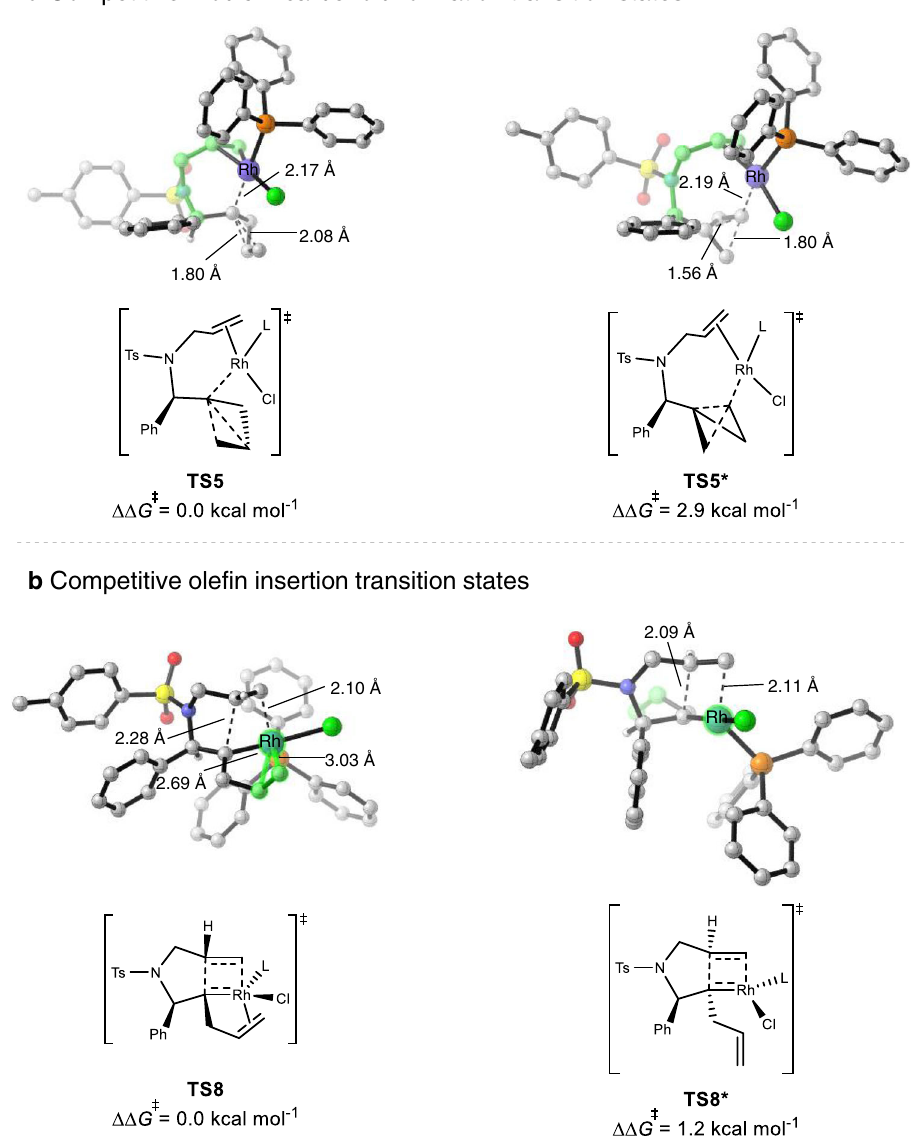
Fig. 6 | DFT analysis of the origins of regio- and diastereoselectivity for Rh(I)/ PPh 3 -catalyzed cycloisomerizations. DFT-optimized structures of a rhodium carbenoid formation and b ole fi n insertion transition states involved in Rh/PPh 3